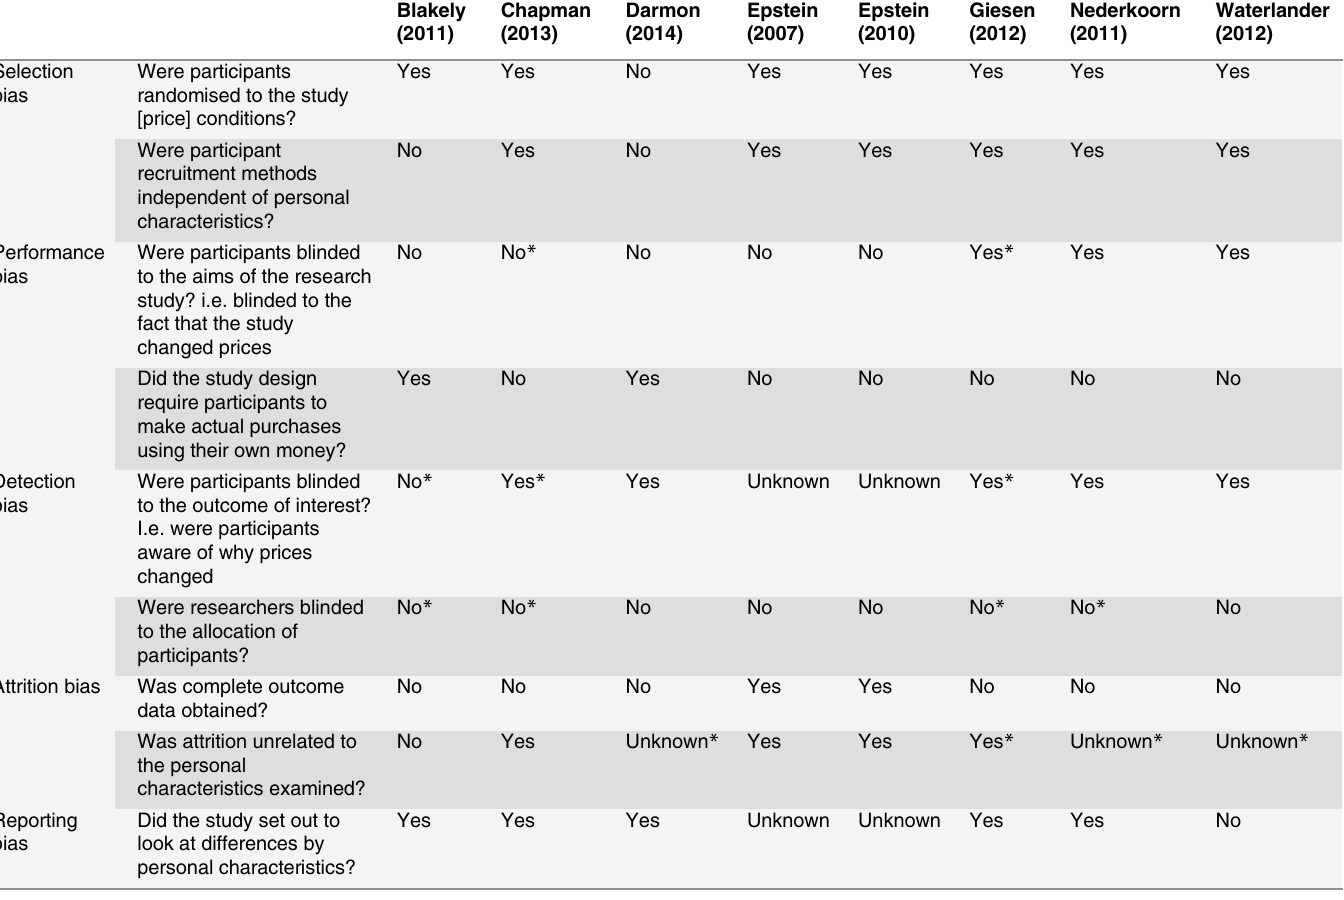
Table 5. Assessment of the quality of included